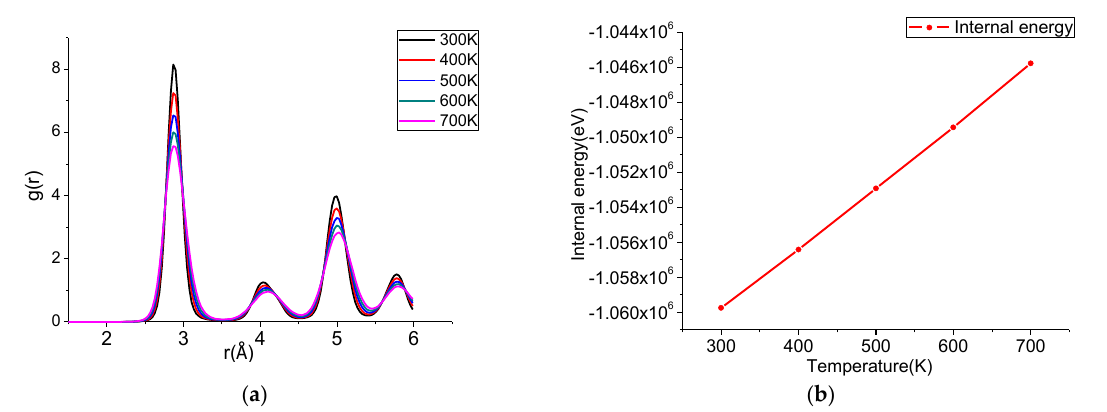
Figure 4. The atomic number of the structure during annealing: ( a ) the atomic number of the structure during heating; ( b ) the atomic number of the structure during cooling.